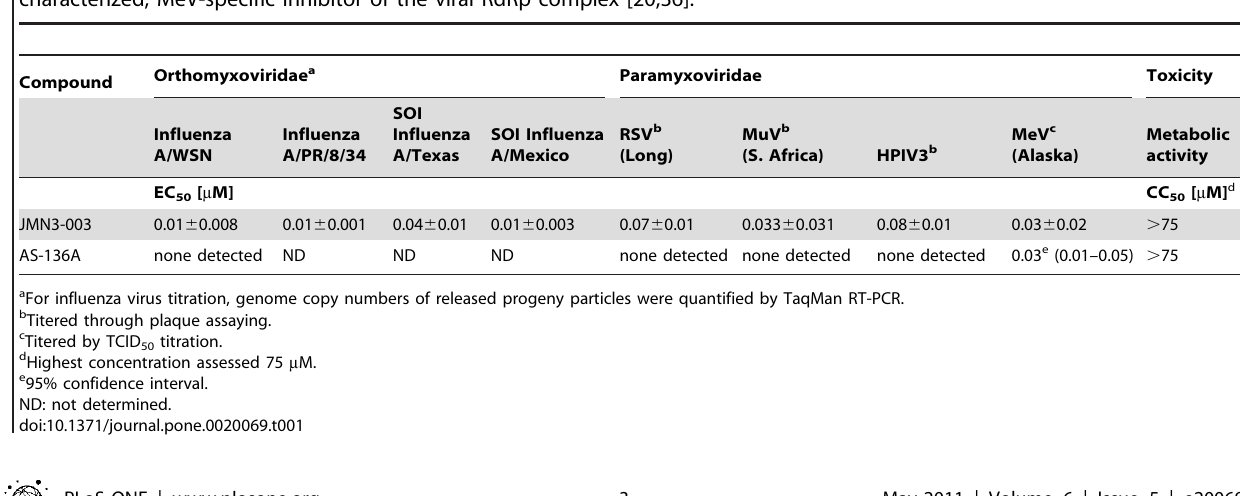
After a 60-minute exposure, approximately 80% of the input material remained intact, corresponding to an extrapolated half- life of approximately 200 minutes (figure 3A). Unstable analogs of JMN3-003, JMN5-165 and JMN5-166 (figure S1), returned half